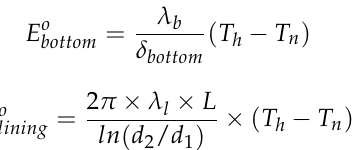
Figure 7. ( a ) Schematic diagram and ( b ) image of the improved crucible and molten pool struc- ture.